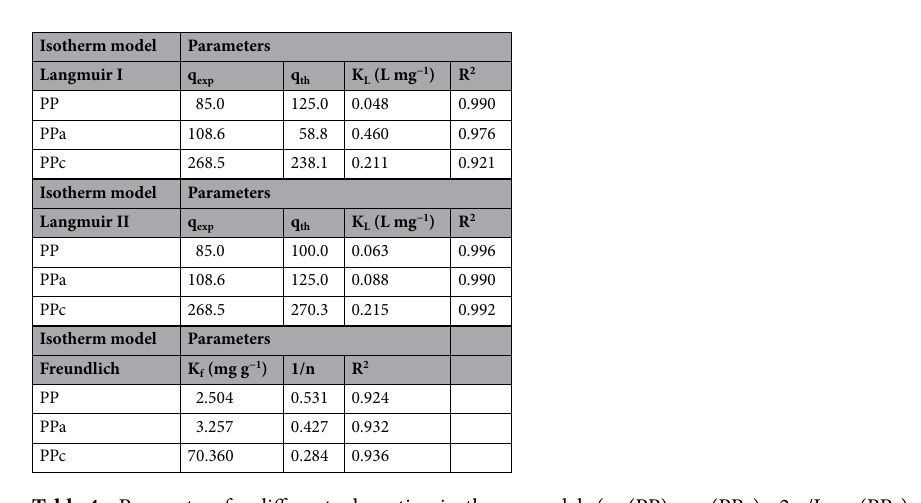
Table 4. Parameters for different adsorption isotherm models (m (PP) = m (PPa) = 2 g/L, m (PPc) = 0.6 g /L; pH =